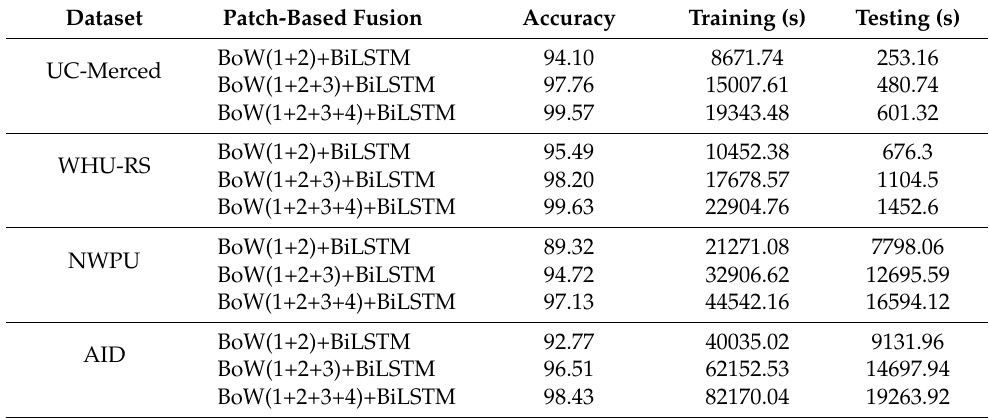
Table 2. The general comparison of the proposed method after information fusion in terms of accuracy (%), training and testing time per